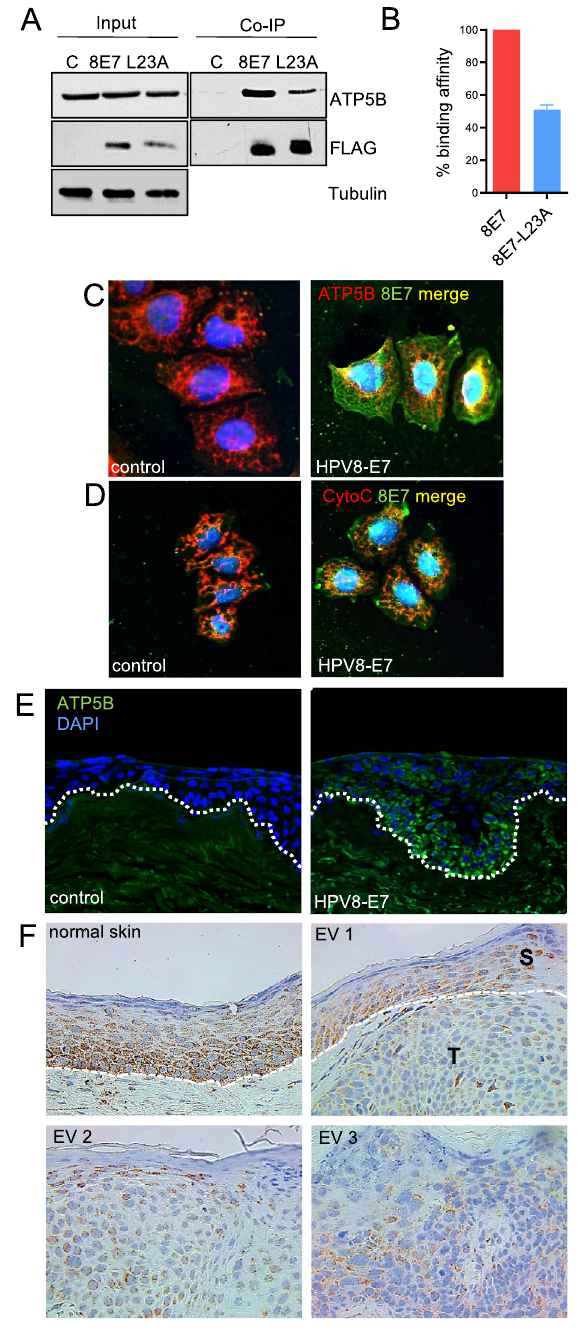
Figure 1. Interaction and co-localization of HPV8-E7 and ATP5B. ( A ) Representative immunoblots of Co-IPs performed with whole protein lysates of C33a cells transiently transfected either with pCMV2-FLAG empty vector, pCMV2-HPV8-E7- FLAG or pCMV-8E7 L23A -FLAG. Cell extracts were incubated with M2-FLAG agarose beads. Co-immunoprecipitated ATP5B bound to HPV8-E7-FLAG was detected by immunoblotting with specific antibodies. The expression of HPV8-E7-FLAG was confirmed by a Western blot analysis against FLAG. Equal loading was ensured by staining for tubulin as a control. Images were cropped from different gels for better clarity. Original Western blots presented are available in Supplemental Fig. S2. ( B ) Statistical analysis of n = 4 independent Co-IP experiments. ( C ) C33a cells grown on coverslips were immunocytochemically stained to confirm co-localization of HPV8-E7 and ATP5B (DAPI: blue, ATP5B: red, HPV8-E7: green, overlay: yellow, magnification 600 ×). ( D ) C33a cells grown on coverslips were immunocytochemically stained to confirm localization of HPV8-E7 to mitochondria (DAPI: blue, mitochondria-associated protein Cytochrome C: red, HPV8-E7: green, overlay: yellow, magnification 600 ×). ( E ) Immunofluorescence stainings of organotypic skin cultures of N/TERT keratinocytes either harbouring the empty vector pLXSN (left image) or pLXSN-HPV8-E7 (right image). Elevated ATP5B levels are observed in basal and suprabasal cell layers in the HPV8-E7 culture, and lighter signals in more suprabasal areas (magnification 200 ×). ( F ) Representative immunohistochemical staining of normal human skin as well as non-lesional EV skin and EV skin tumors (EV1/EV2 are positive for betaHPV types 5, 36; EV3 is positive for betaHPV types 5, 8, 20, 23, 36, 50) (magnification 400